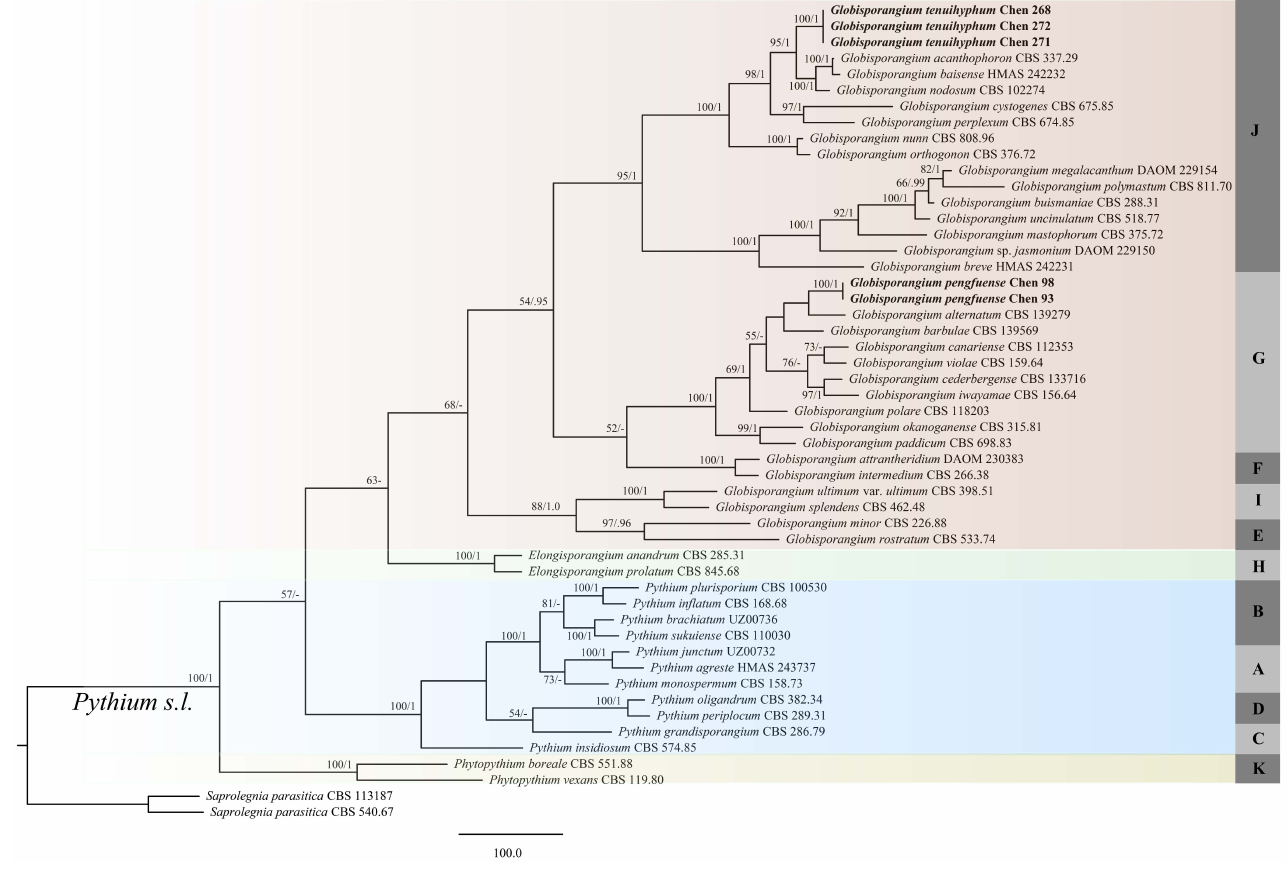
Figure 1. Phylogeny of Globisporangium pengfuense , G. tenuihyphum , and related species generated by maximum parsimony based on ITS + Cox1 sequences. The branches are labeled with parsimony bootstrap proportions (before the slanting line) higher than 50% and Bayesian posterior probabilities (after the slanting line) ≥ 0.95. The new species are indicated in bold. Ph . refers to Phytopythium